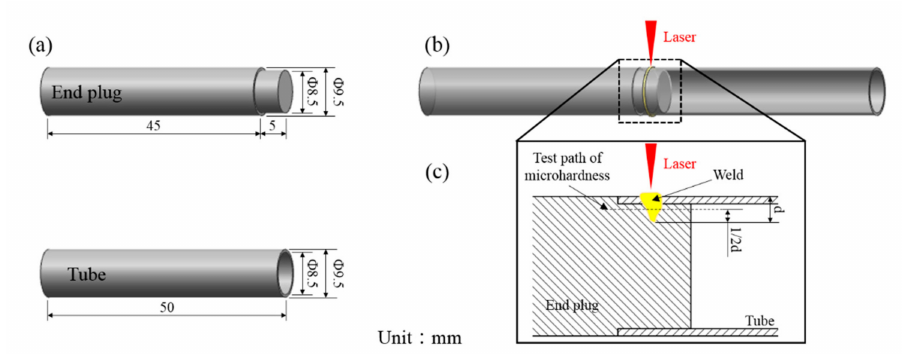
Figure 2. Schematics of the materials and methods: ( a ) dimensions of the NS Mo alloy end plug and tube; ( b ) laser beam irradiation zone on the specimen during welding tests; ( c ) cross-section of the weld joint.